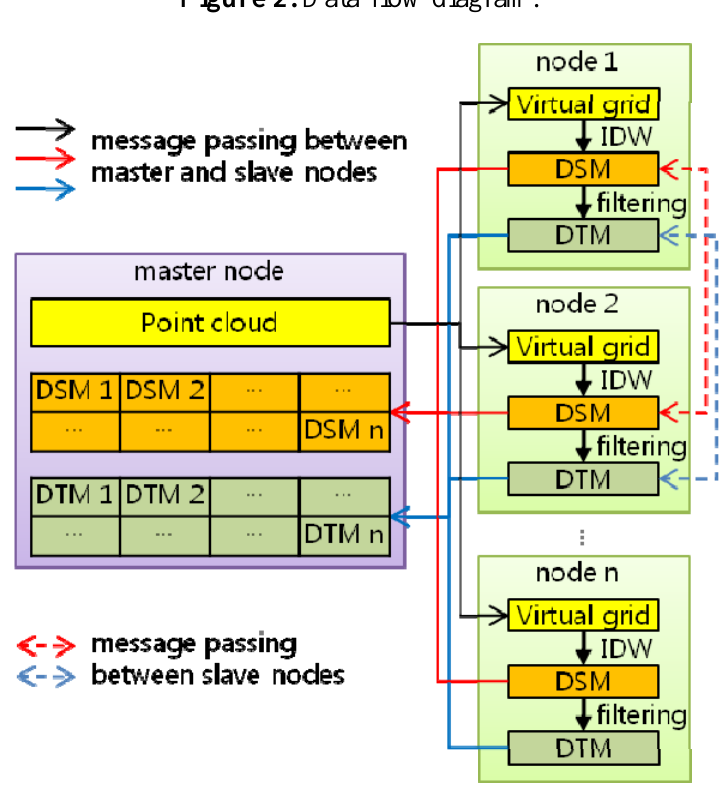
Figure 2. Data-flow